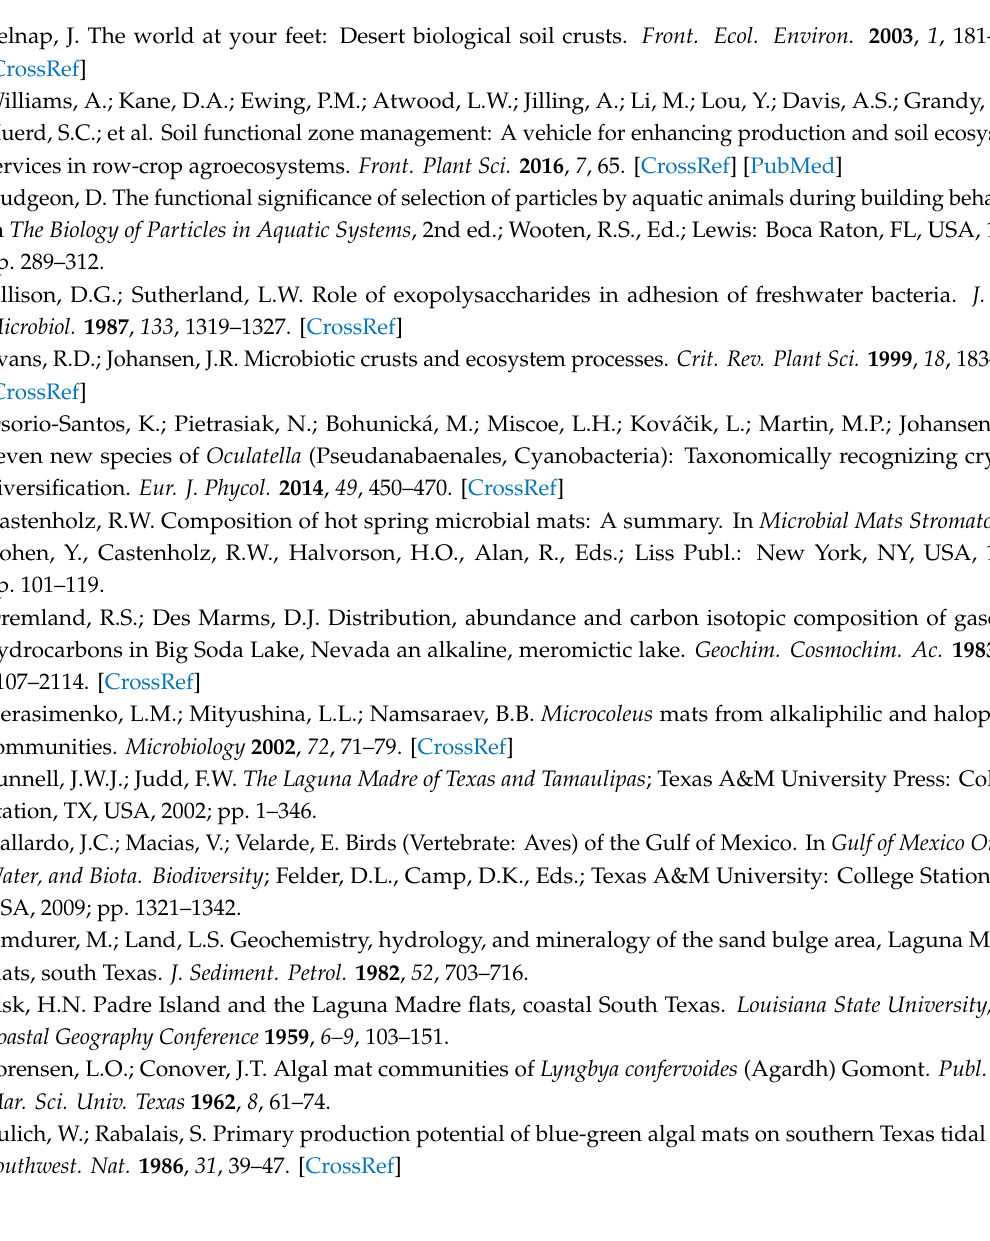
Figure S7: Bar plot showing the relative abundance of Proteobacteria amplified sequences separated by regions and conditions, Figure S8: Bar plot showing the relative abundance of cyanobacterial species amplified sequences separated by regions and